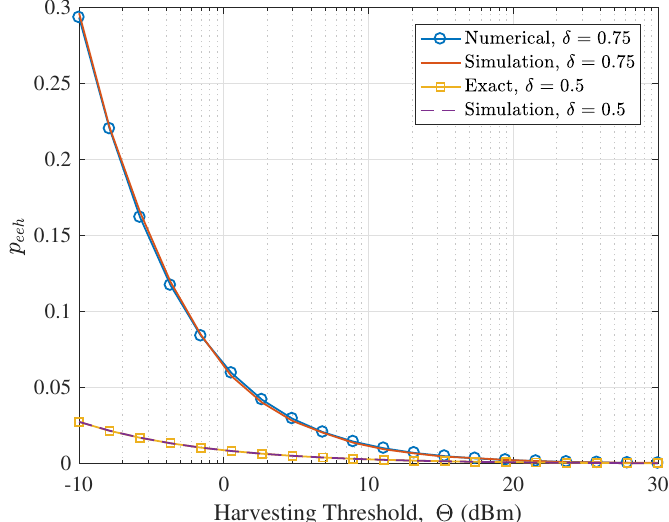
Figure 3. Effective energy harvesting probability for LSWN-IC with λ t = 0.0001, α = 4, η a = 1 and P et = 30